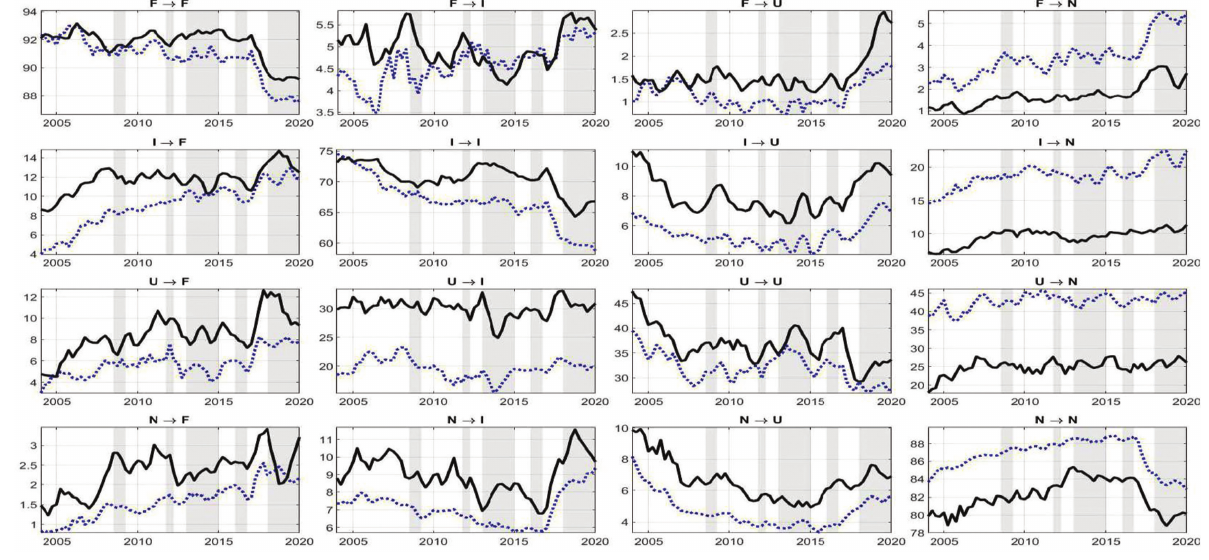
Source : Argentine Household Survey. The solid black lines are the transitions for men and the dashed blue are those for women. “F,” “I,” “U,” and “N” indicate formal employment, informal employment, unemployment, and nonparticipation, respectively. For example, “ → F I ”: the transition from formal to informal work. Shaded areas denote recession periods based on the Argentine Central Bank (BCRA)